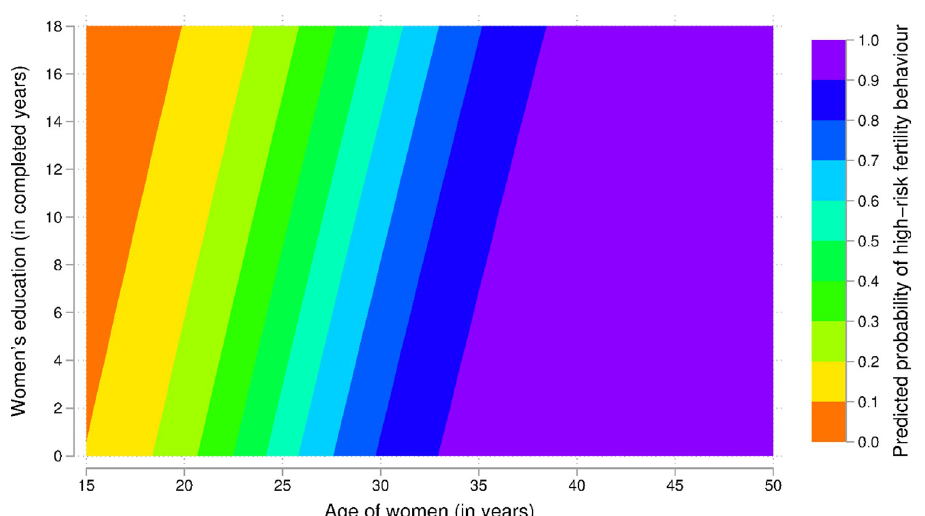
Fig 3. Predicted probability of high-risk fertility behaviour by age and education among married women in the Democratic Republic of the Congo.